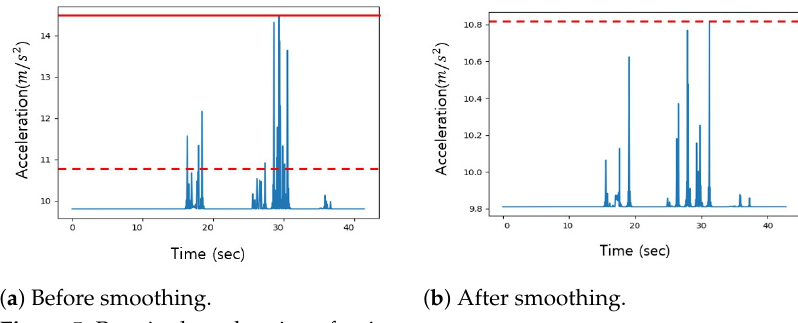
Figure 5. Required acceleration of trajectory.